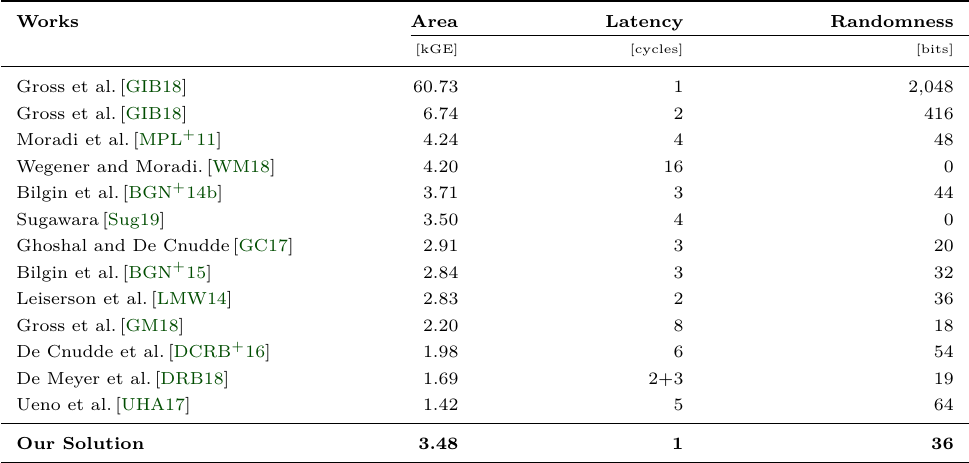
Table 3: Comparison of masked AES S-box implementations and their